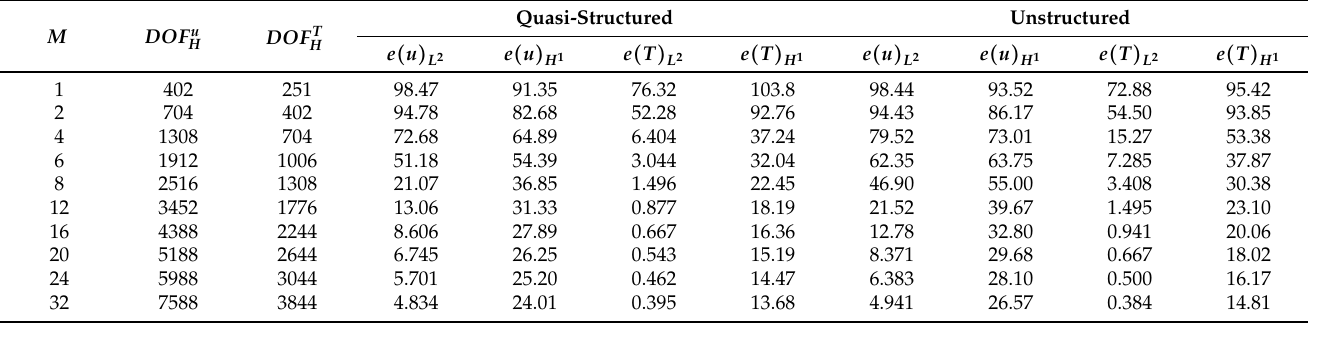
Table A5. Thermoelasticity problem. Case 2 (homogeneous boundary condition for elasticity and non-homogeneous boundary condition for temperature on perforations). Unstructured coarse grids. M = M u = M T . Relative L 2 and H 1 error in %. DOF h = 170,460.